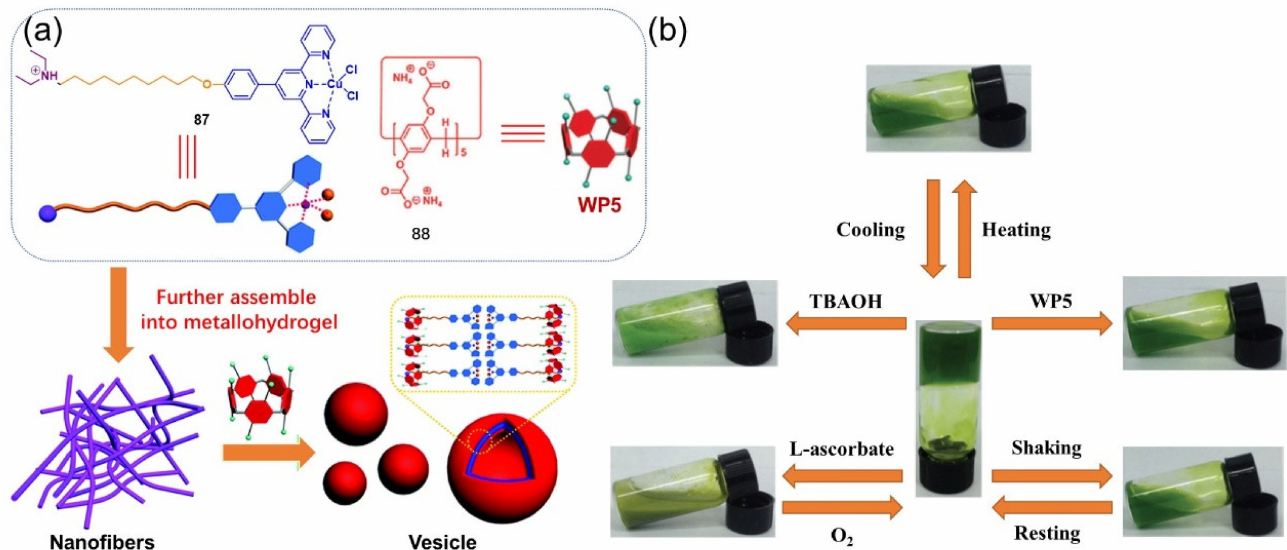
Figure 35. ( a ) Chemical structures of ligands 87 and anionic water-soluble pillar[5]arene WP5 88 , and cartoon representations of the gelation process and WP5-induced morphology transformation. ( b ) Photographs of the gel–sol transitions of the metallohydrogel triggered by different stimuli. Reprinted with permission from Ref. [110]. Copyright (2015), Royal Society of